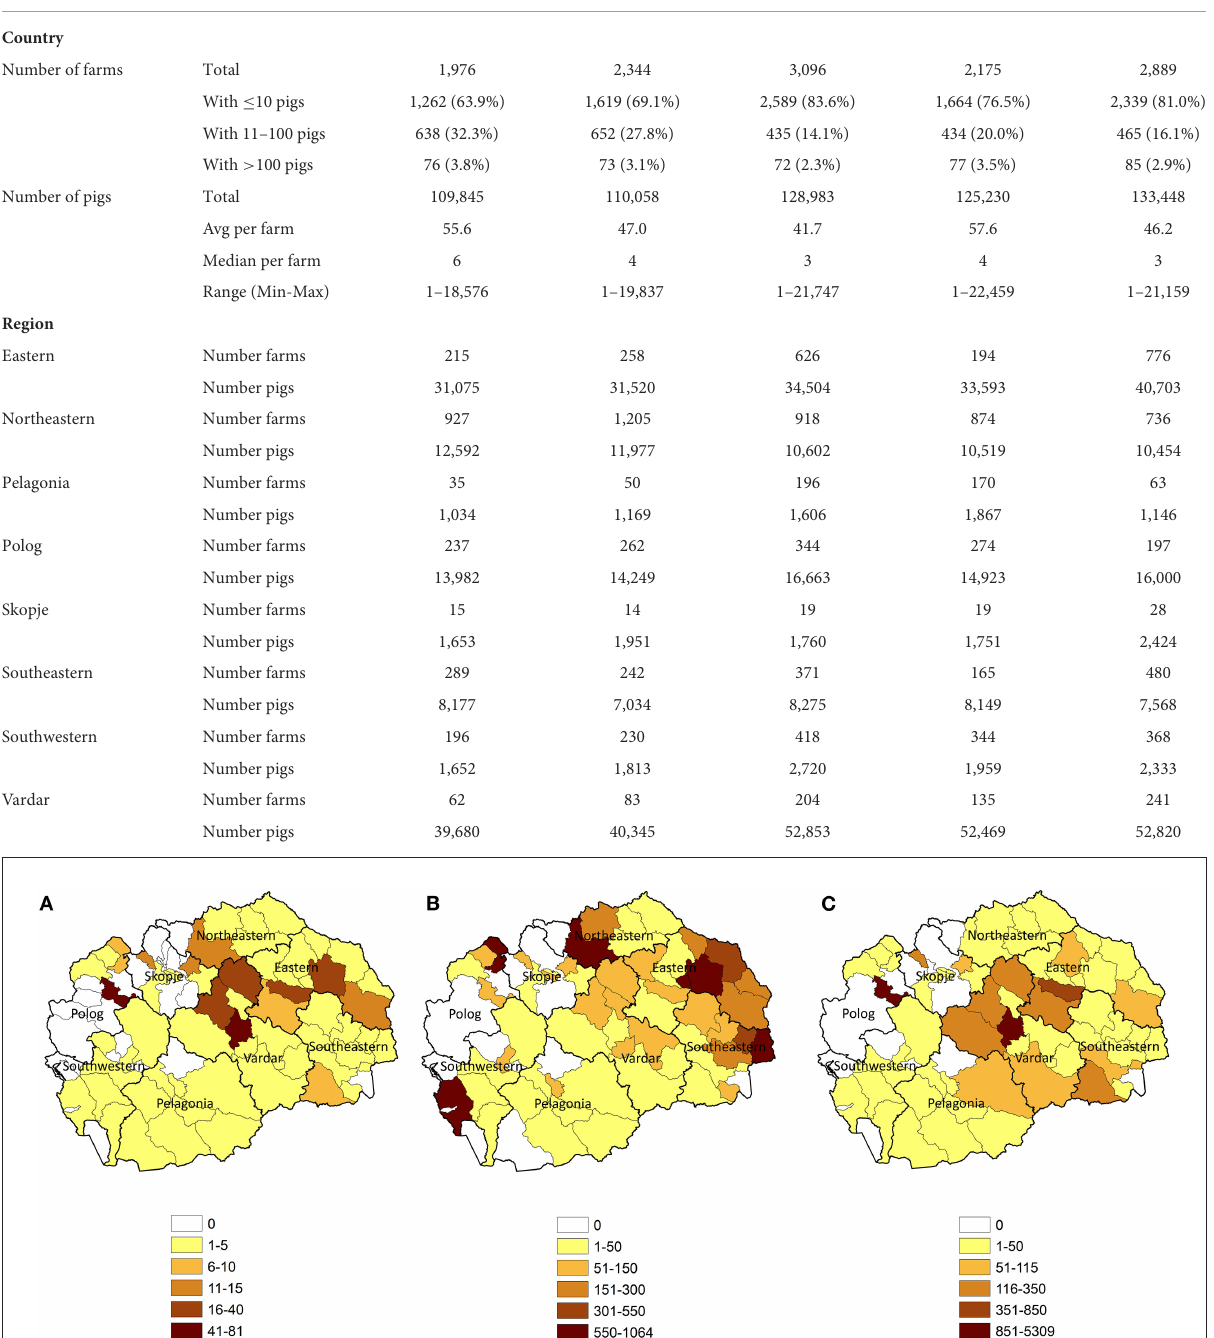
FIGURE1 North Macedonian 2020 pig census summarized at the municipality level by (A) pig per square kilometer, (B) farms per 1,000 square kilometers, and (C) pigs by farm. Black lines outline regions. Gray lines outline